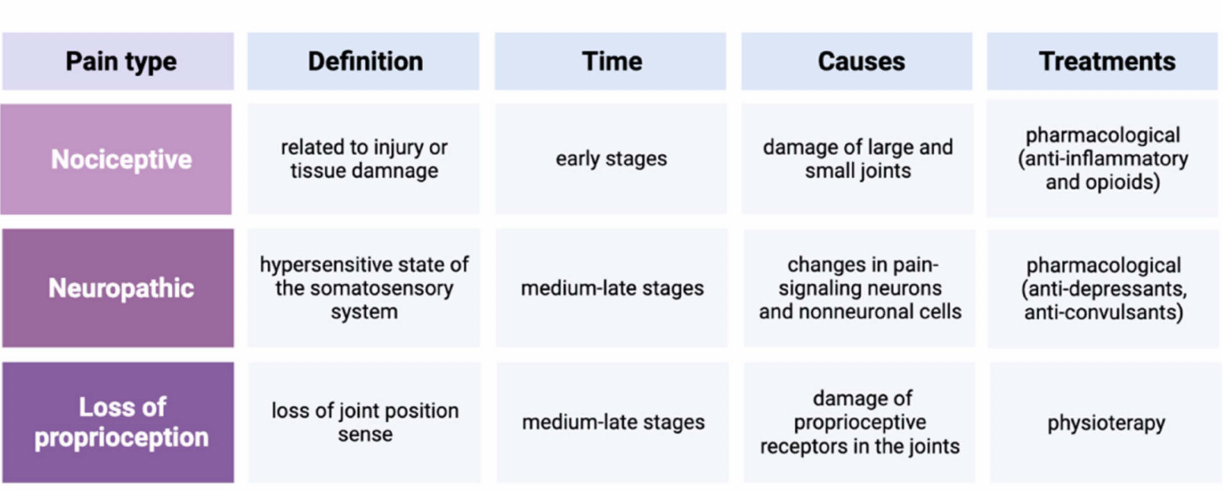
Figure 2. Correlation of EDS pain and management